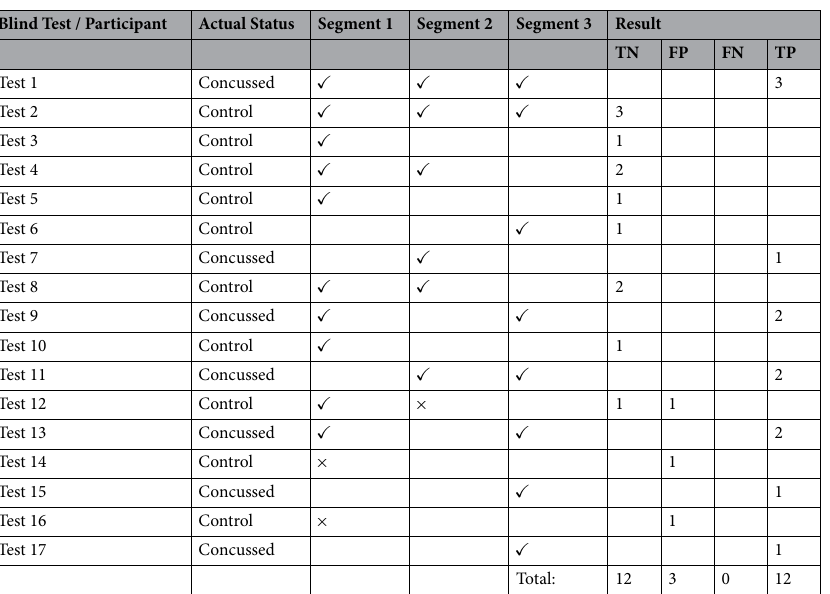
Table 3. Details of the Stage 1 test results for ConcNet . The table shows the number of distinct segments from any one participant that were present in the blind test sample, and how each of these were classified. All except one pair were consistently—and correctly—classified. Final column gives the results in terms of the number of True Negative (TN), False Positive (FP), False Negative (FN) and True Positive (TP). These are further summarized in the Confusion Matrix in Fig. 2.